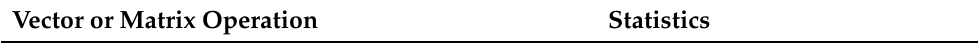
Table 16. Raspberry Pi III B+ benchmark statistics for vector and matrix operations with k = 128 (times in ms).